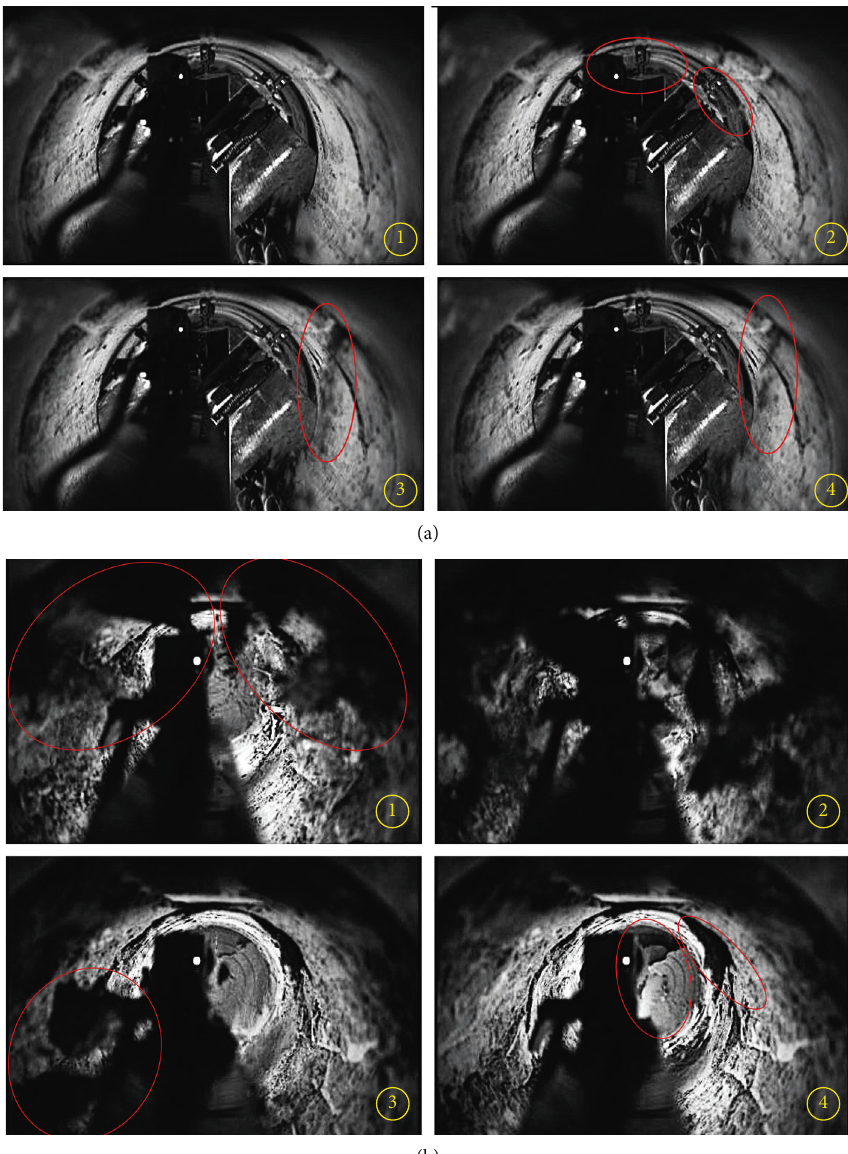
Figure 17: Damage monitoring under shock in: (a) the second shock; (b) the third